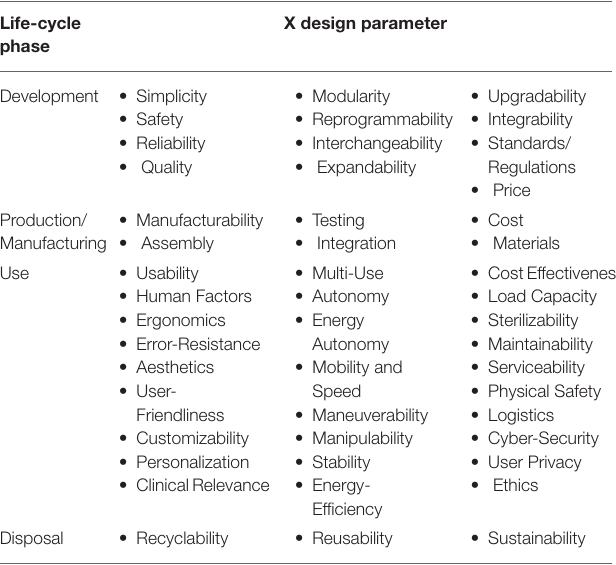
TABLE 1 | Design requirements summary using the “Design for X”